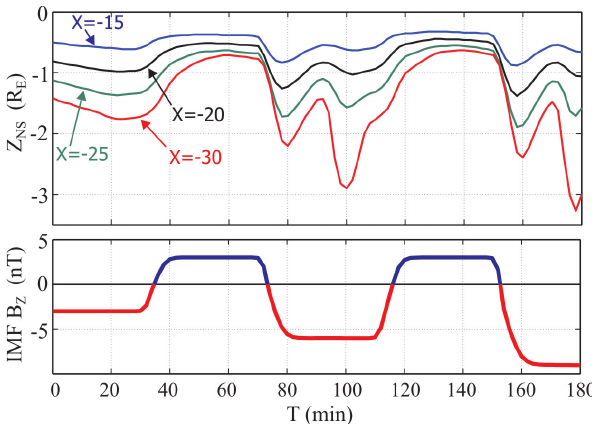
Figure 13. Time variation of the neutral sheet position Z NS at four tailward distances (top panel), in a MHD simulation run (BATSRUS at the Coordinated Community Modeling Center (CCMC)) with a constant IMF B x = 6nT and varying IMF B z (bottom panel). Southward excursions of Z NS (up to − 3 R E at X = − 30 R E ) oc- cur during the periods with IMF B z <